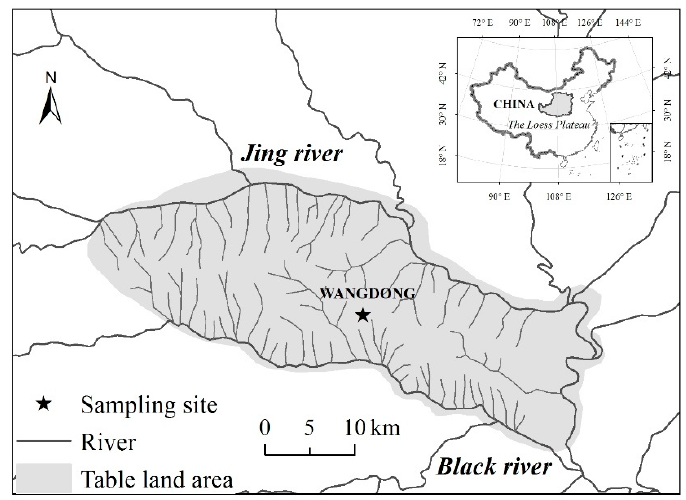
Figure 1. The locations of sampling sites.